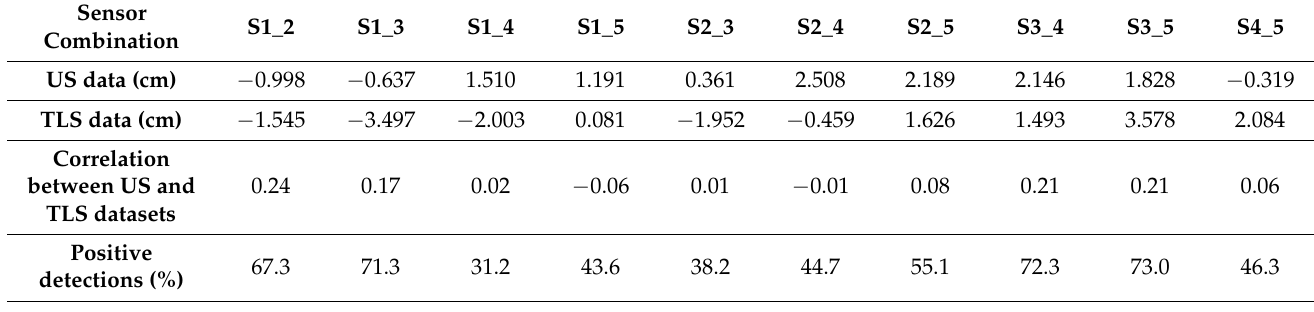
Table 2. Mean sensor (S) height differences (Sn_k = S n − S k ) of the recording type road scanner (US), and terrestrial laser scanner (TLS), and the compartment on positive matches of sensor pairs considering a positive or negative height differ- ence.